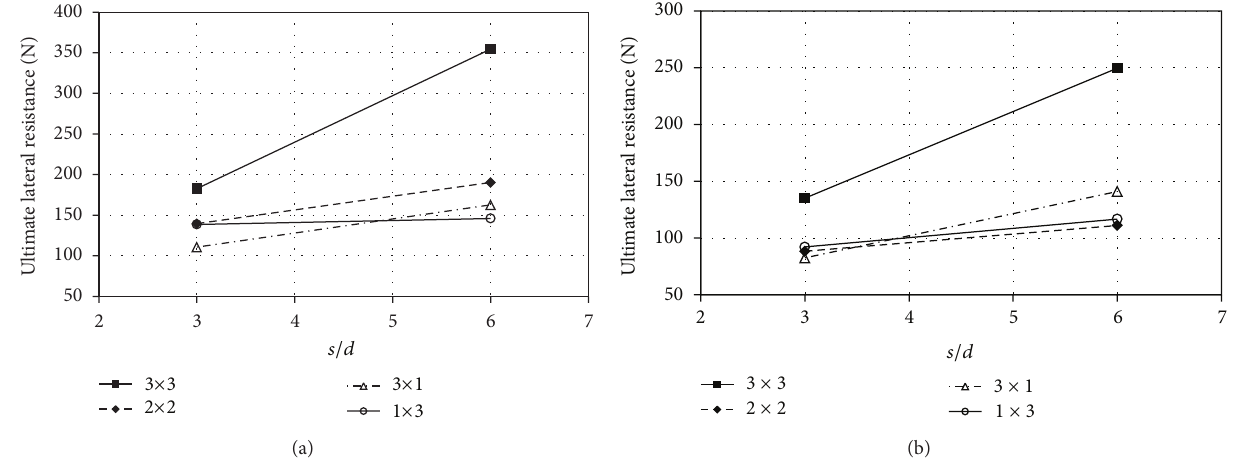
Figure 10: Ultimate lateral load versus pile spacing; (a) 𝐷 𝑟 =75% and (b) 𝐷 𝑟